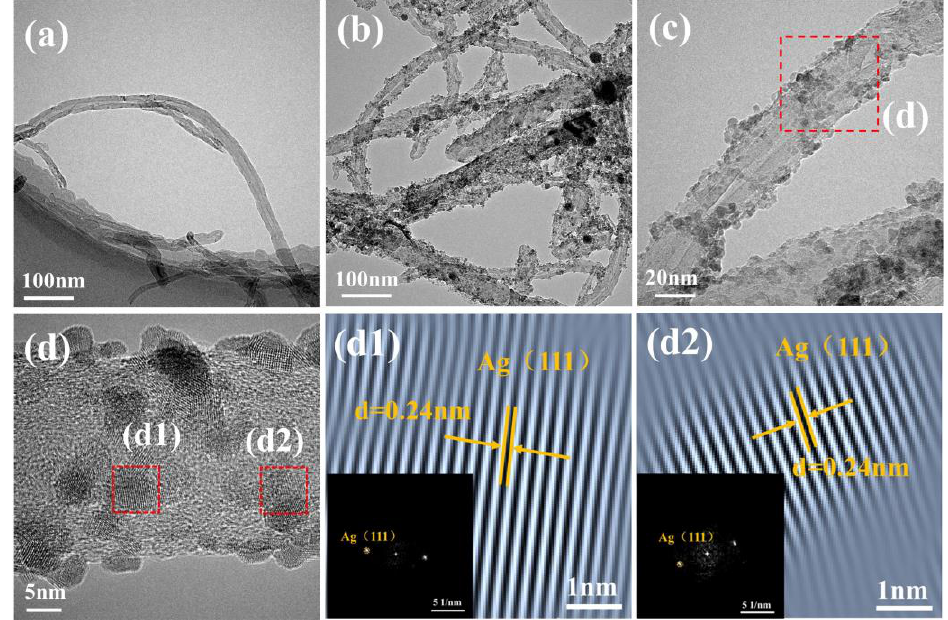
Figure 4. ( a ) TEM images of pristine CNTs; ( b , c ) TEM images of Ag-CNTs; ( d ) HRTEM images of Ag-CNTs; ( d1 , d2 ) FFT and IFFT images of the red dashed box in Figure 4d.